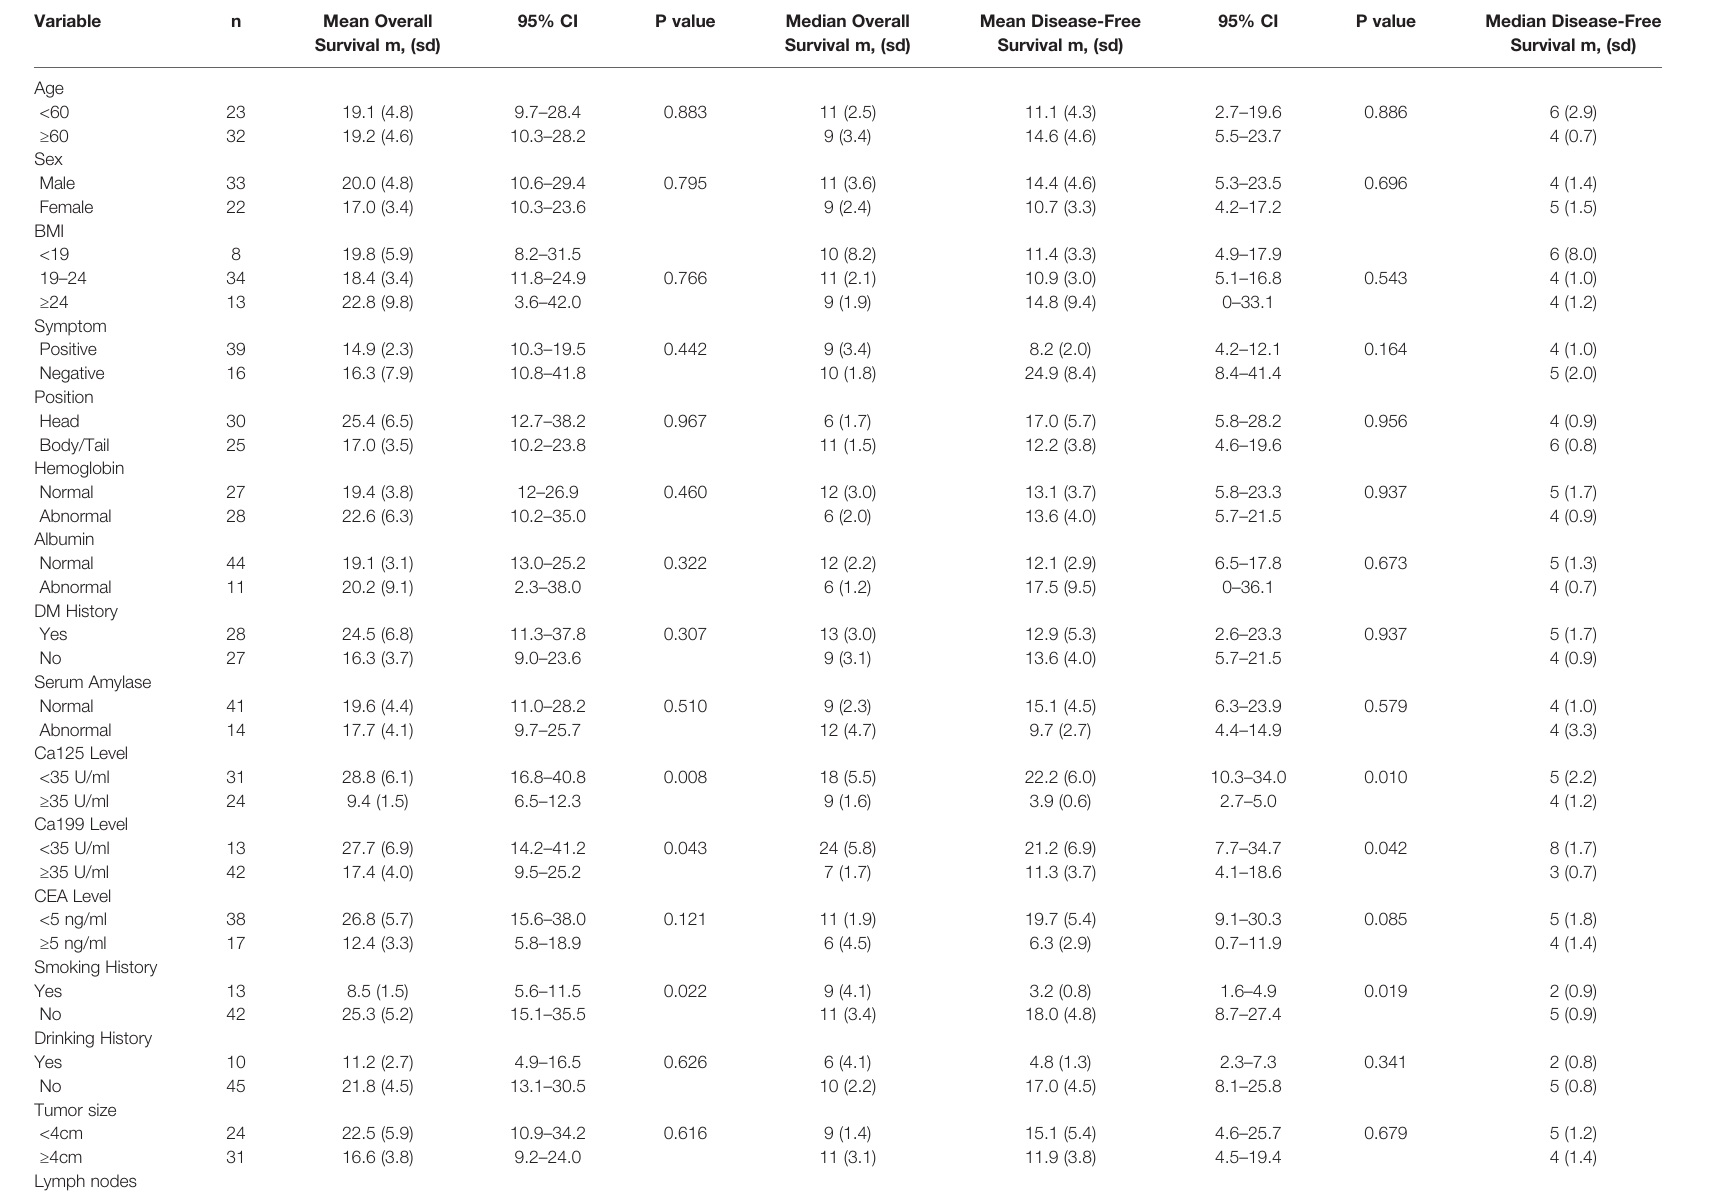
TABLE 1 | Demographic data and univariate analysis of risk